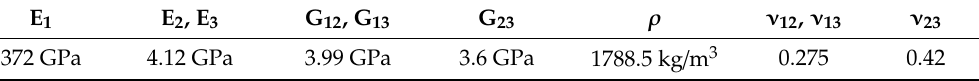
Table 1. Material properties of a single lamina of the laminated plate.